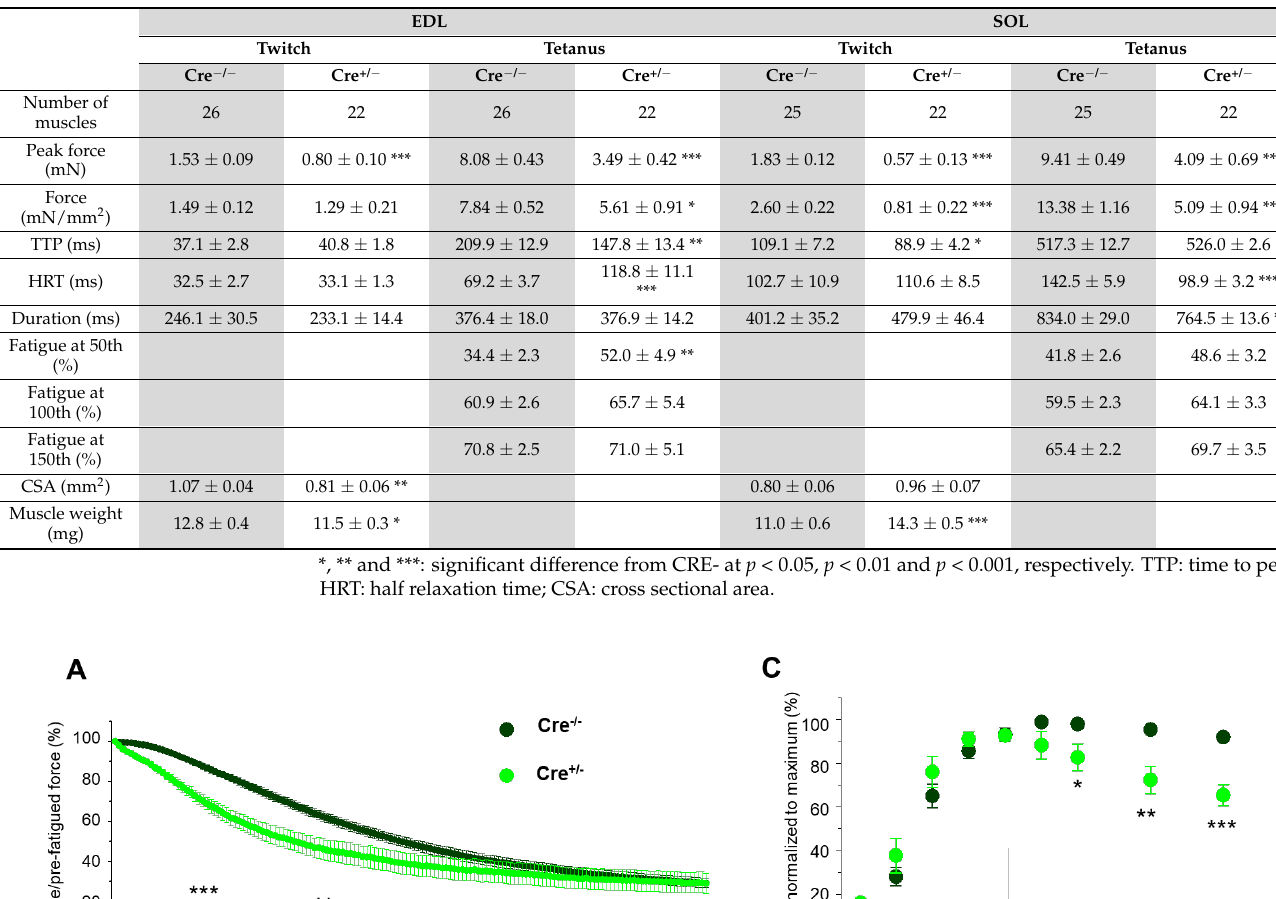
Table 1. Parameters of twitch and tetanus in EDL and SOL muscles.